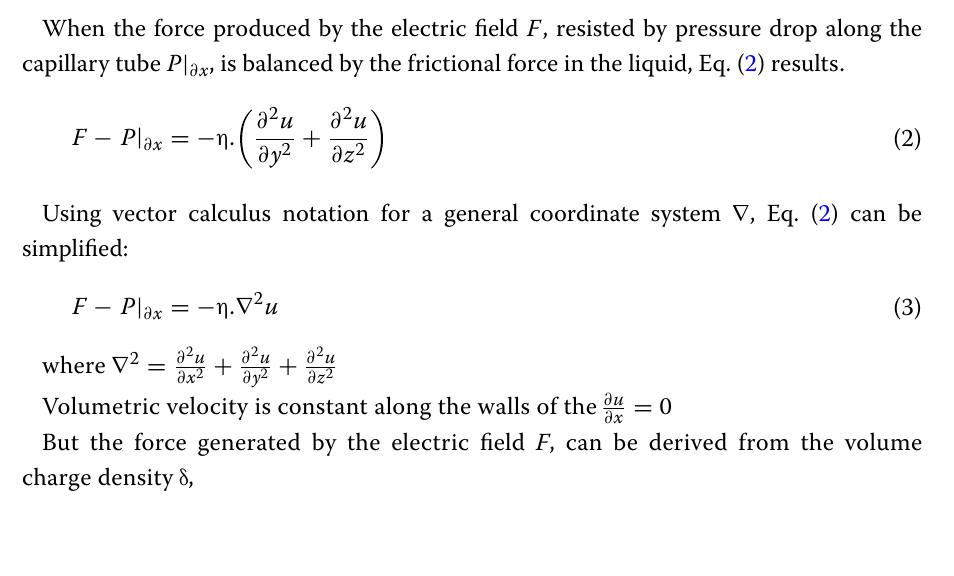
Table 2 Comparative analysis between various thermal Electrical EOR techniques as presented by Rehman and Meribout [53] EK‑EOR type Induction heating -Reservoirs with thief zones -Reservoirs where thermal EOR is not suitable -Reservoirs having low in situ water saturation Low-frequency electric heating -Can be used as alternative to steam injection depending on the